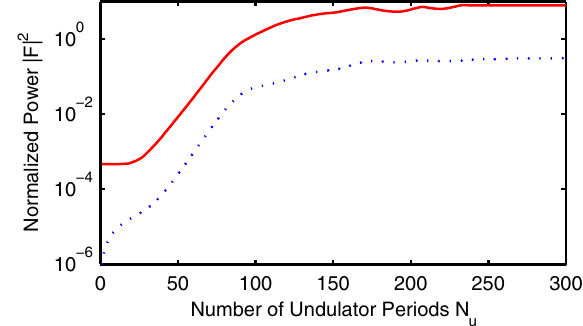
FIG. 3. The peak (solid red curve) and average (dotted blue curve) power as a function of the undulator distance.